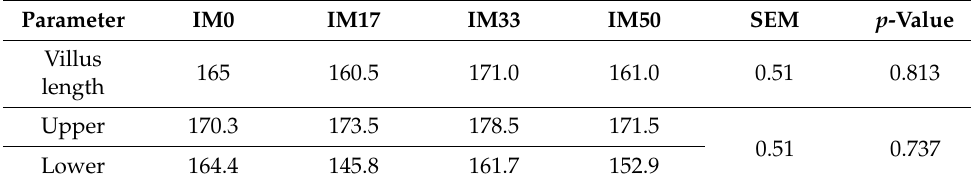
Table 4. Villus length ( µ m) of the fish fed with different Hermetia illucens meal (IM) dietary inclusion and FM replacement rates. For each treatment, the villus length is also reported for the upper and lower surface of the intestinal lumen.